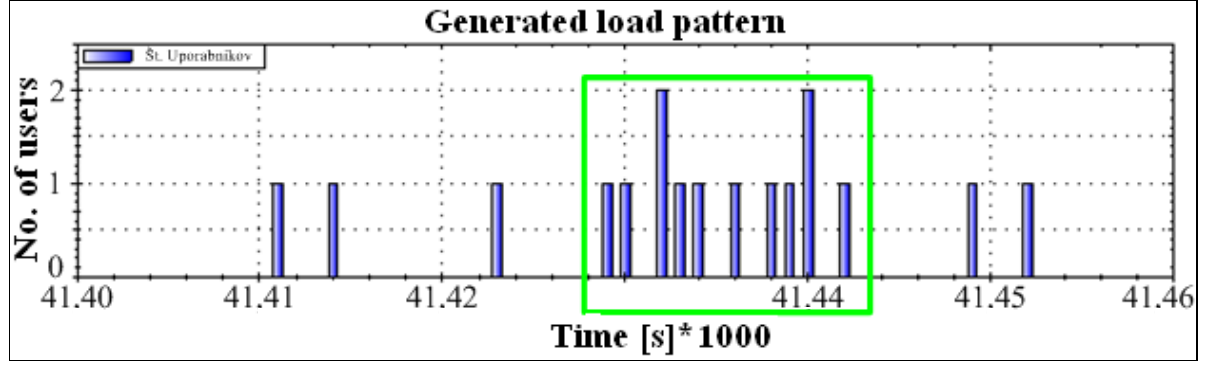
Figure 17. Activity and utilization of the service charging system in the entire observed period. P = 15, U = 17. As the purpose of the proposed method is the exact prediction of the service capaci ‐ ties, we tested this prediction on the considered system. We set the threshold at 0% for rejected users. All users must receive service without rejections or queues. We seek a so ‐ lution that complies with the set criteria with considerable repeatability by increasing or decreasing the service capacity parameter and considering the allowed percentage of re ‐ jected users based on the implemented automatic optimization loop. With all the random patterns and considering all the criteria, the method suggests the capacity of seven charg ‐ ing places. We also considered a random load pattern concentration possibility. By this, we also incorporate the possibility of a random pattern concentration. The following fig ‐ ure depicts an interim example of the service system utilization with an automatic search and optimization of the service capacity number. The method, in this case, performed the initial nine iterations with a decrementation of the initial parameter from 15 to 6 service places. The obtained result automatically performed twenty more random patterns with the same capacity and initial data. The method always predicts a reserve percentage